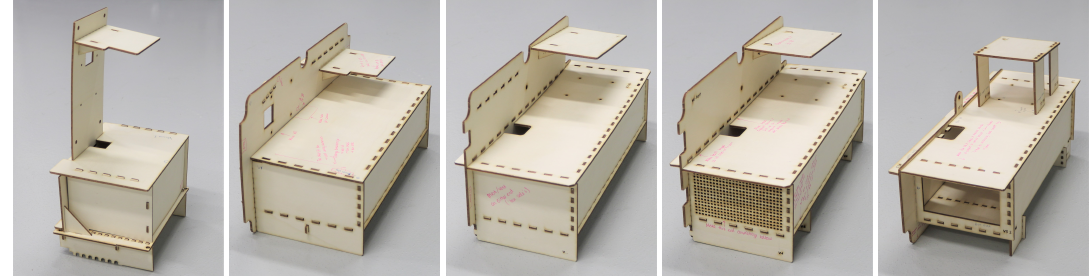
Figure 5. The major changes in the evolution of the Air Quality (AQ) Internet of Things (IoT) interior. Five of twenty-one versions are shown. The final fully populated, acrylic version is shown in Figure